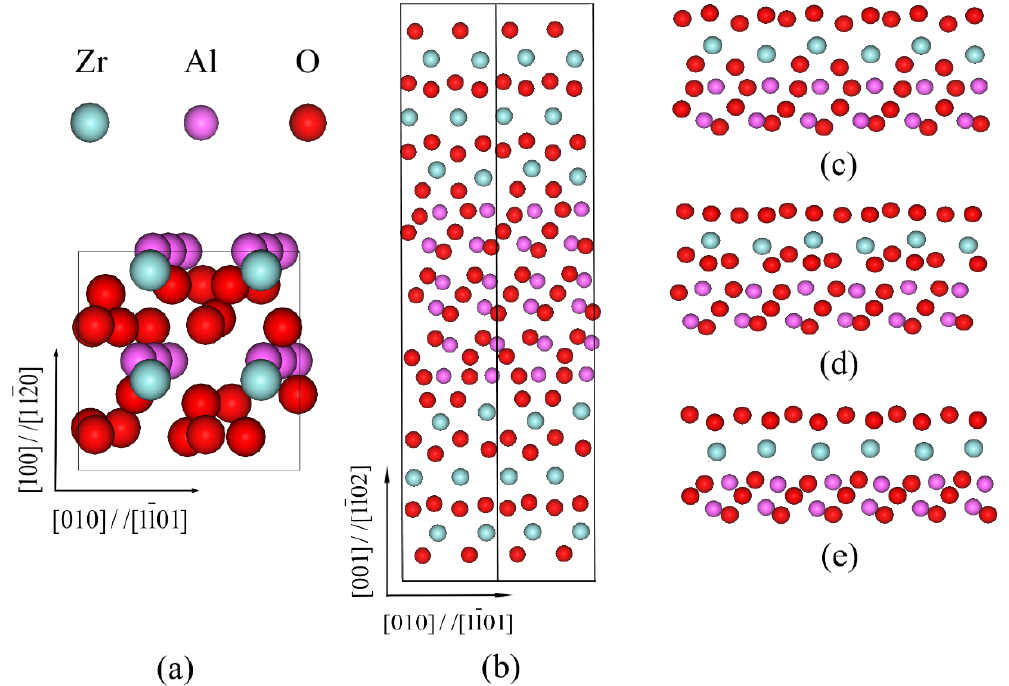
02) interfaces. ( a ) Top view; ( b ) front ̄